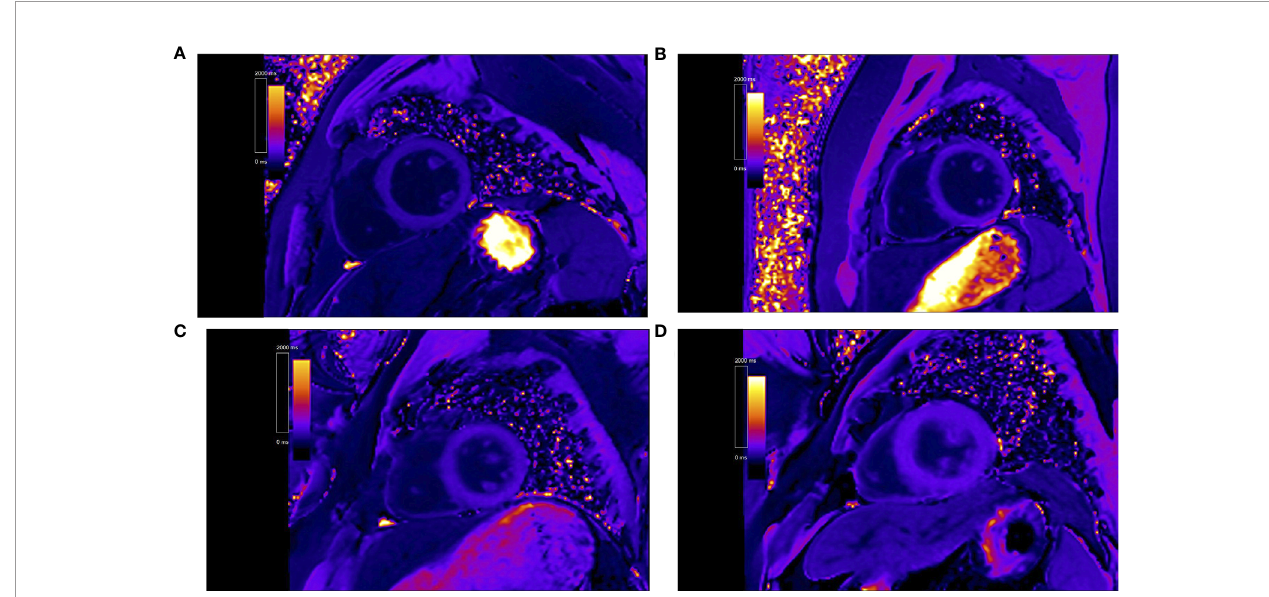
FIGURE 1 | Representative contrast-enhanced T1 maps of primary aldosteronism patients [ (A) patient 1, post T1 of 451.1 ms. (B) patient 2, post T1 of 426.7 ms] and essential hypertension patients [ (C) patient 3, post T1 of 568.4 ms. (D) patient 4, post T1 of 589.5